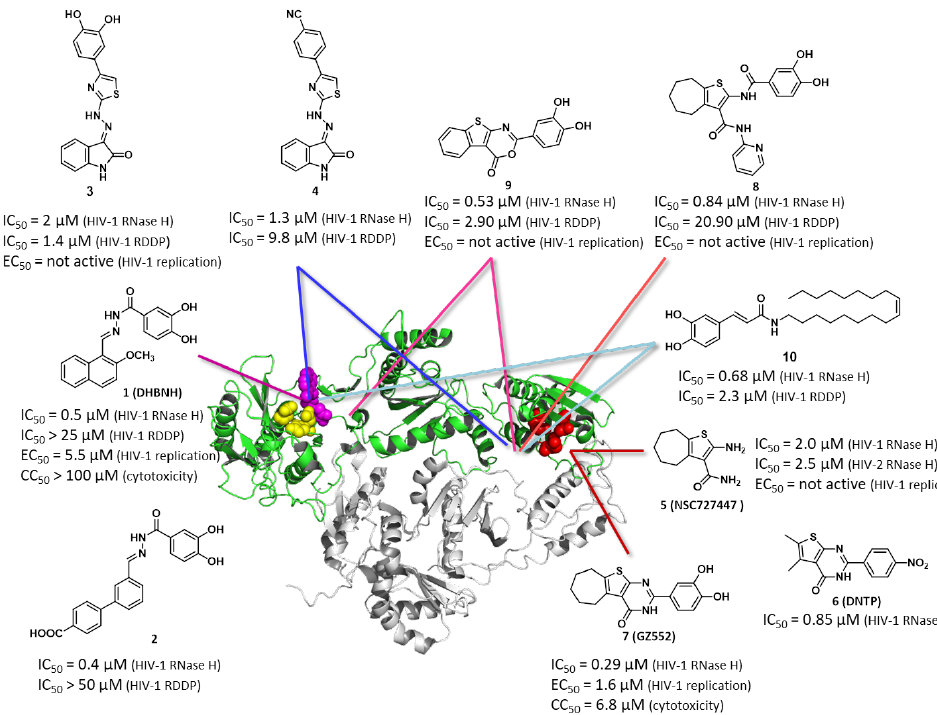
Figure 1. Co-crystal structure of compound 1 (magenta) bound to HIV-1 RT (PDB ID: 2I5J) [17].